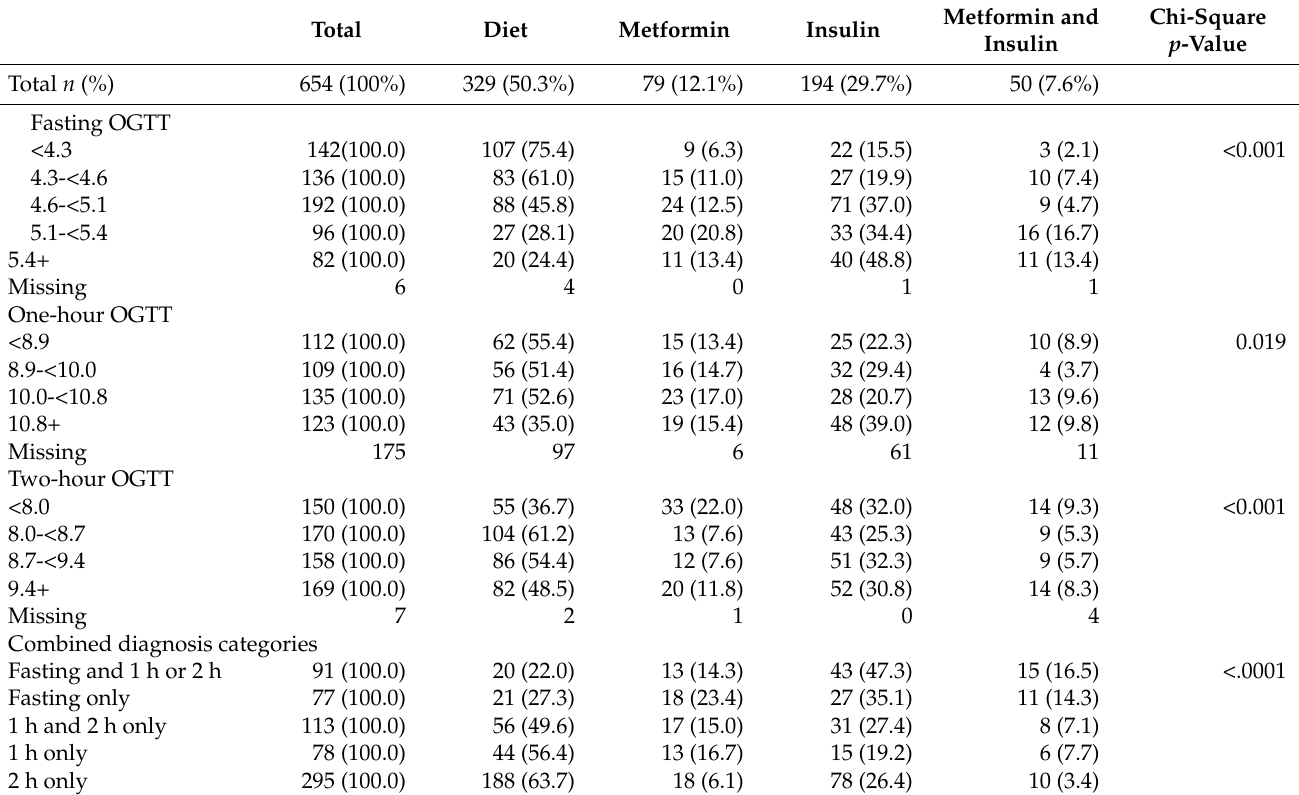
Table 3. Glucose tolerance test results by treatment